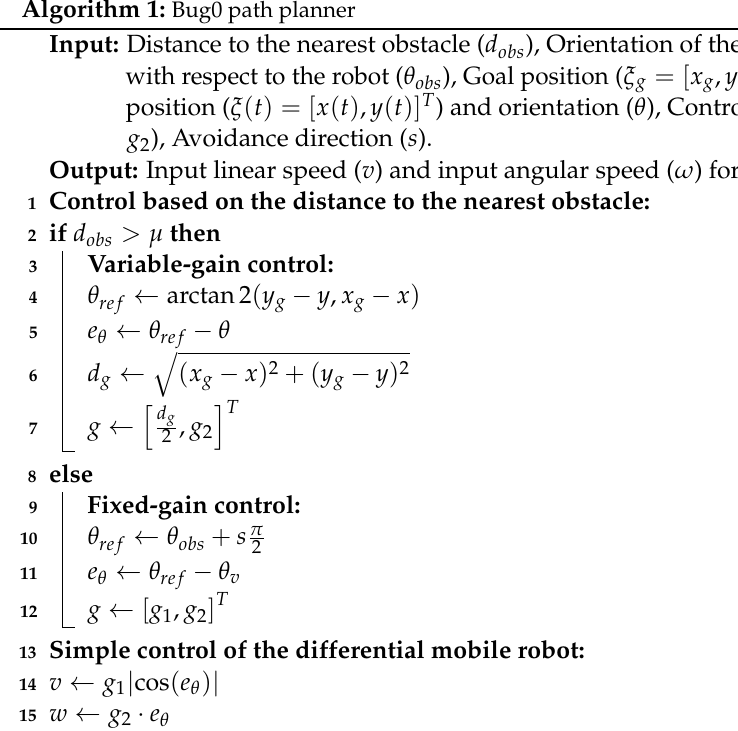
Algorithm 1: Bug0 path